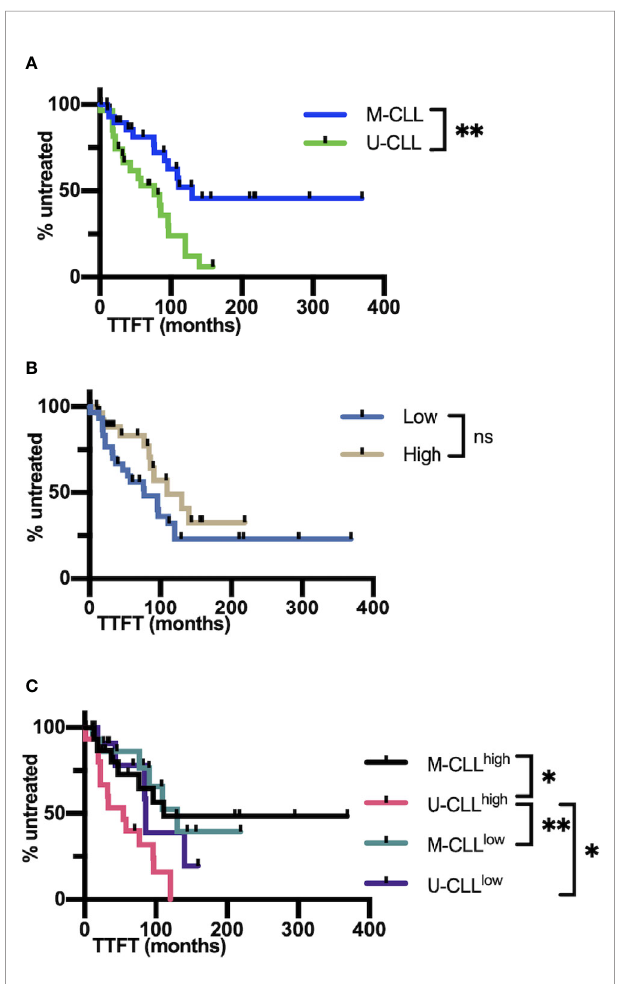
FIGURE 7 | IGHV-D-J complexity correlates with clinical course based on time to fi rst treatment. (A) Time to fi rst treatment (TTFT) in months of the patients falling into the IGHV -mutated (M-CLL; blue) and IGHV -unmutated CLL subsets (U-CLL; green). (B) TTFT in months of the patients falling into the post-CDC complexity categories, Low and High. (C) TTFT (months) of the patients based on a combination of IGHV-mutation status plus the post-CDC complexity categories, U-CLL High , U-CLL Low , M-CLL High , and M-CLL Low . Statistics are displayed only when P-value ≤ 0.05 (* P-value ≤ 0.05, ** P-value ≤ 0.01). NS, Not statistically signi fi